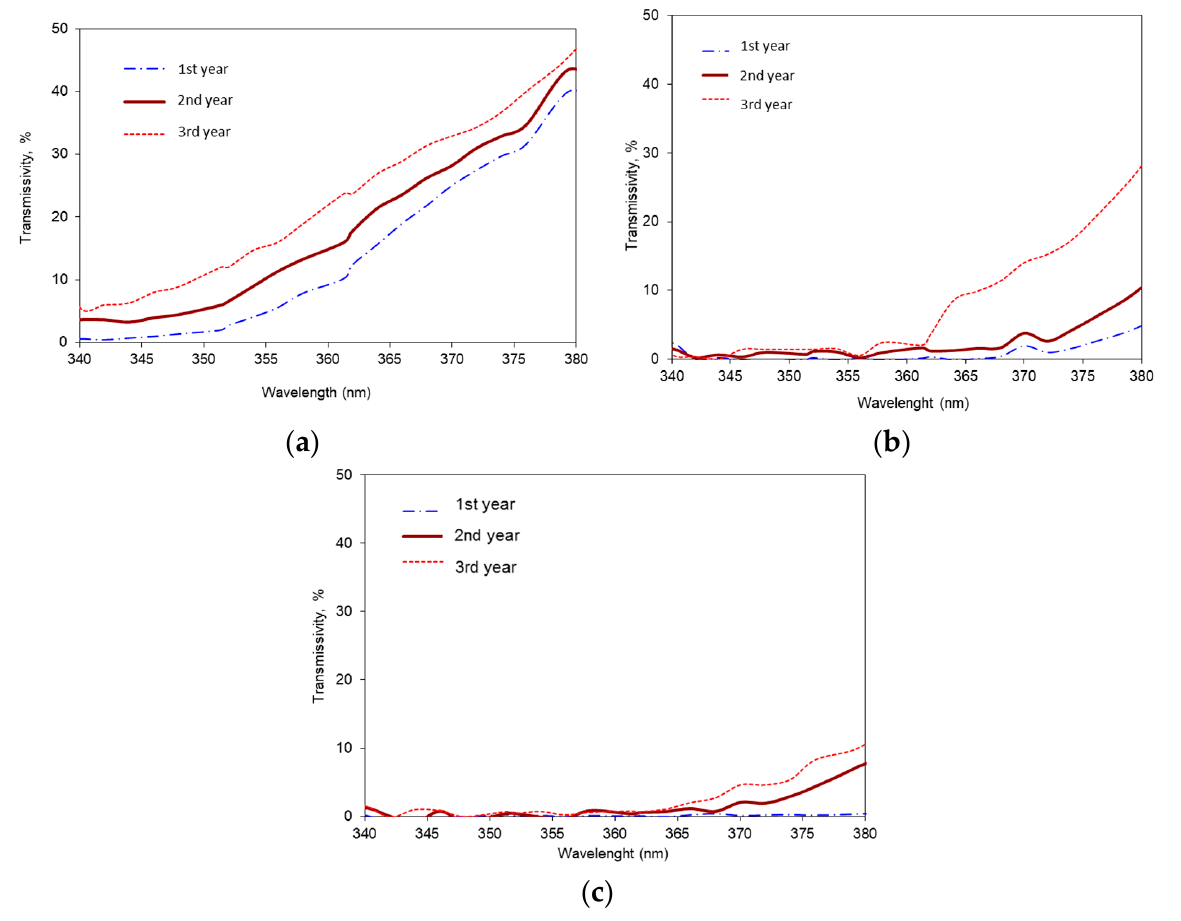
Figure 2. UV-A transmission coefficient evolution of the covering films for three years for: ( a ) UV-5% film; ( b ) UV-3% film; and ( c ) UV-0% film.